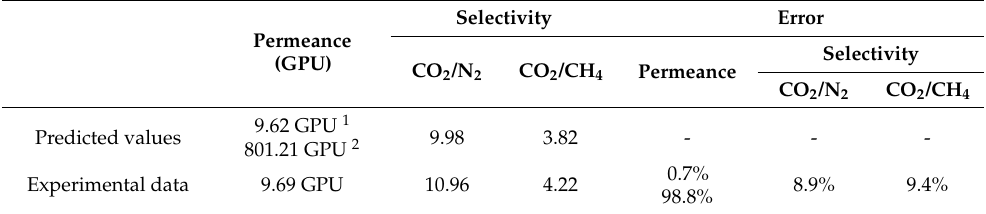
Table 2. Predicted and experimental data of CO 2 permeance in ZIF-L@PDMS/PES composite